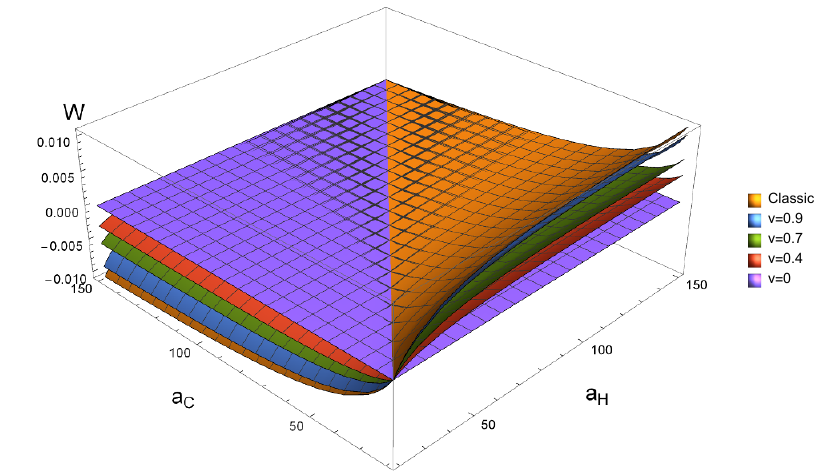
Figure 9. Comparison between the work performed by the Unruh heat engine with di(cid:11)erent qubit velocities and the usual quantum heat engine with a classical thermal reservoir. Here we have used ! 2 (cid:0) ! 1 =